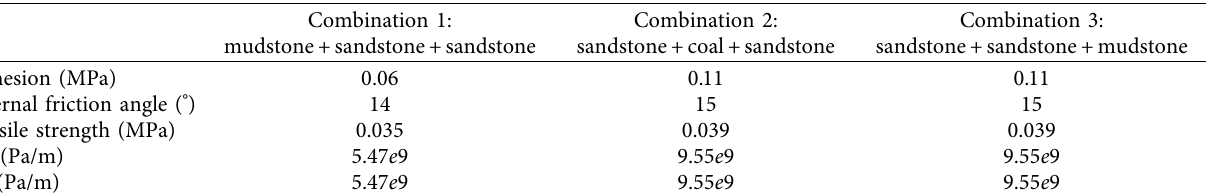
Table 5: Mechanical parameters of the contact surface.